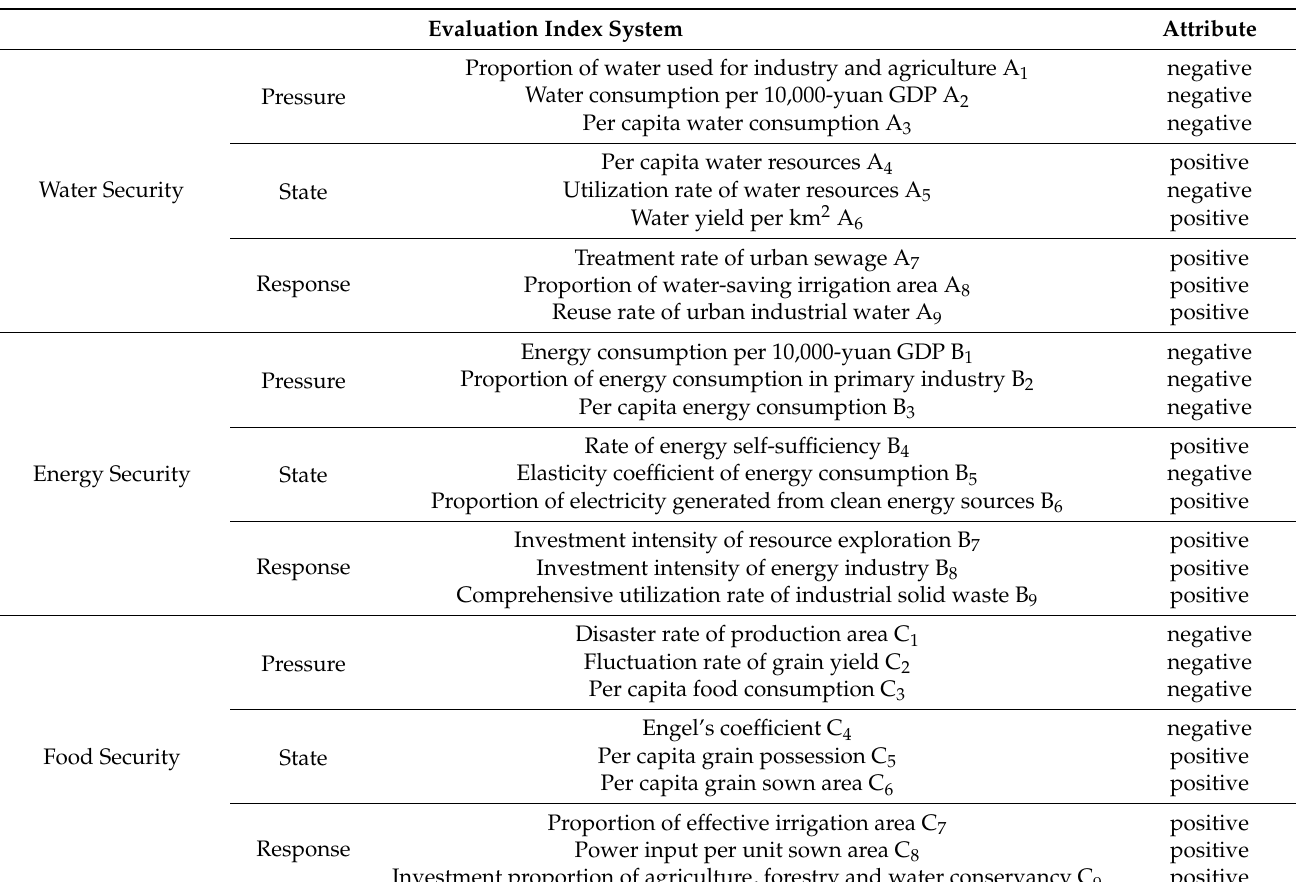
Table 1. Evaluation index system of the water-energy-food system